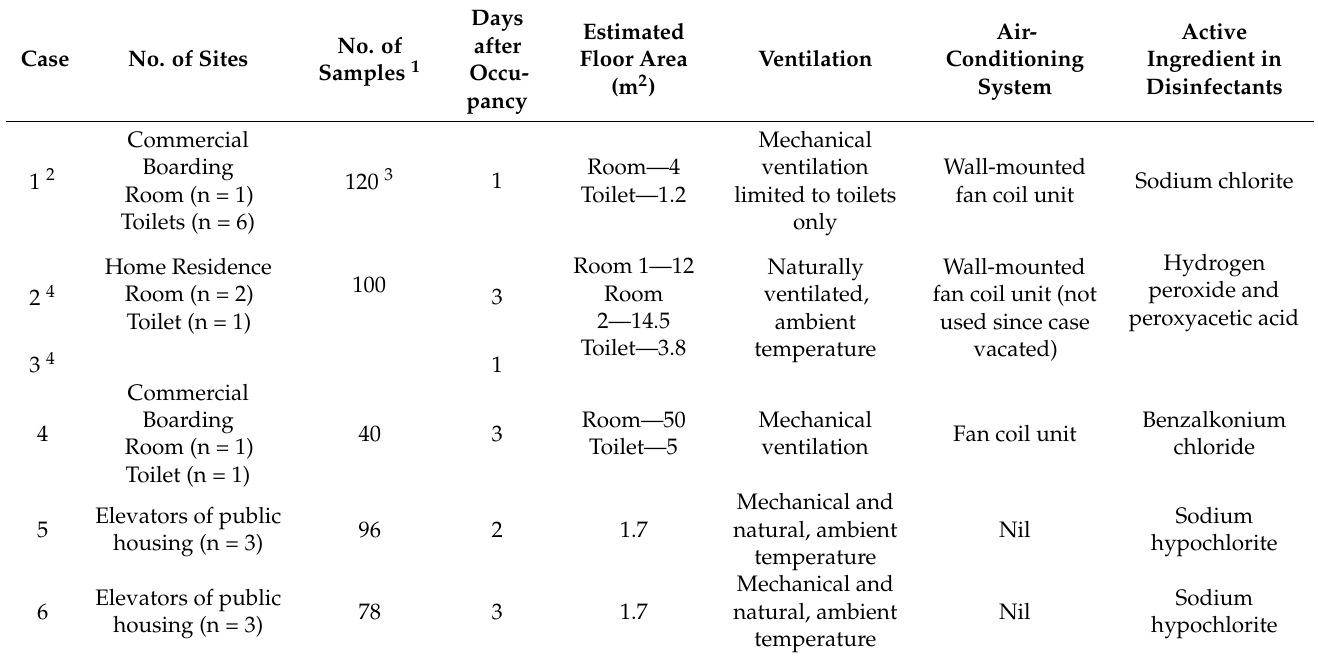
Table 1. Sampling locations, type of air-ventilation and disinfectants used.